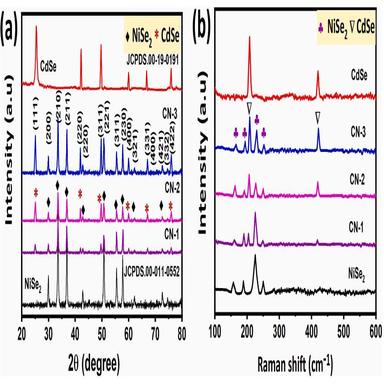
(a,b). XRD diffractogram and Raman shift analysis of the pure and their composites.